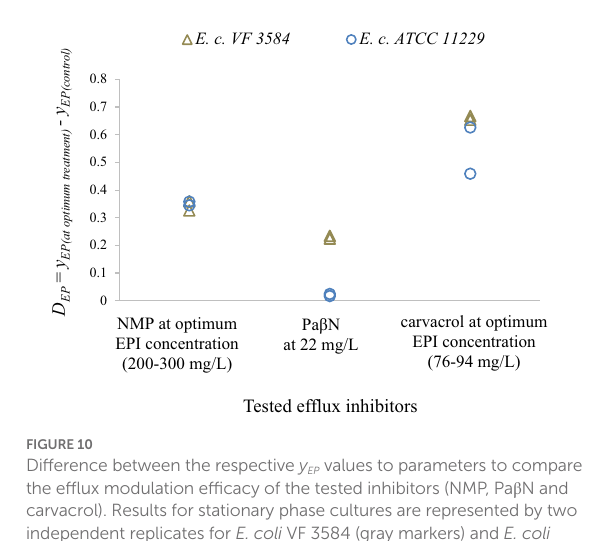
FIGURE 10 Difference between the respective y EP values to parameters to compare the efflux modulation efficacy of the tested inhibitors (NMP, Pa β N and carvacrol). Results for stationary phase cultures are represented by two independent replicates for E. coli VF 3584 (gray markers) and E. coli ATCC 11229 (blue markers). As a control, the y EP values of untreated cultures were